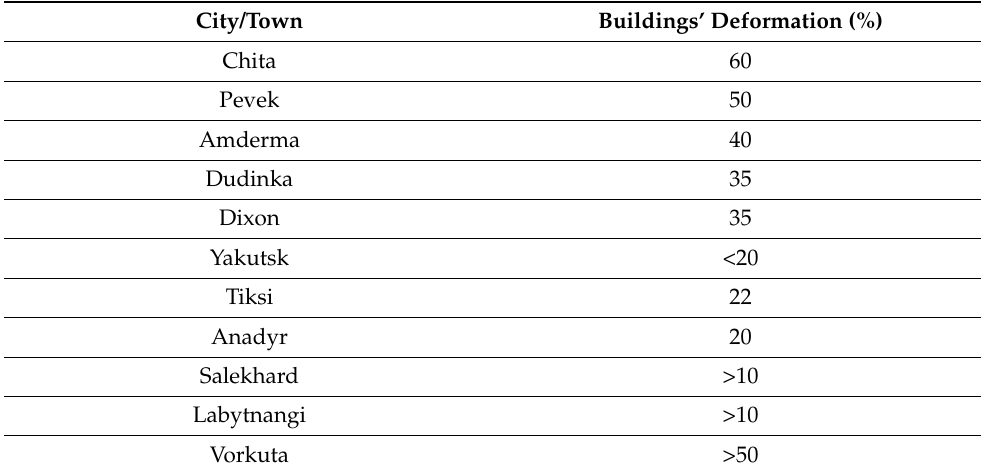
Table 1. The share of buildings in Russian cities and towns in permafrost regions experiencing deformation. Authors data and